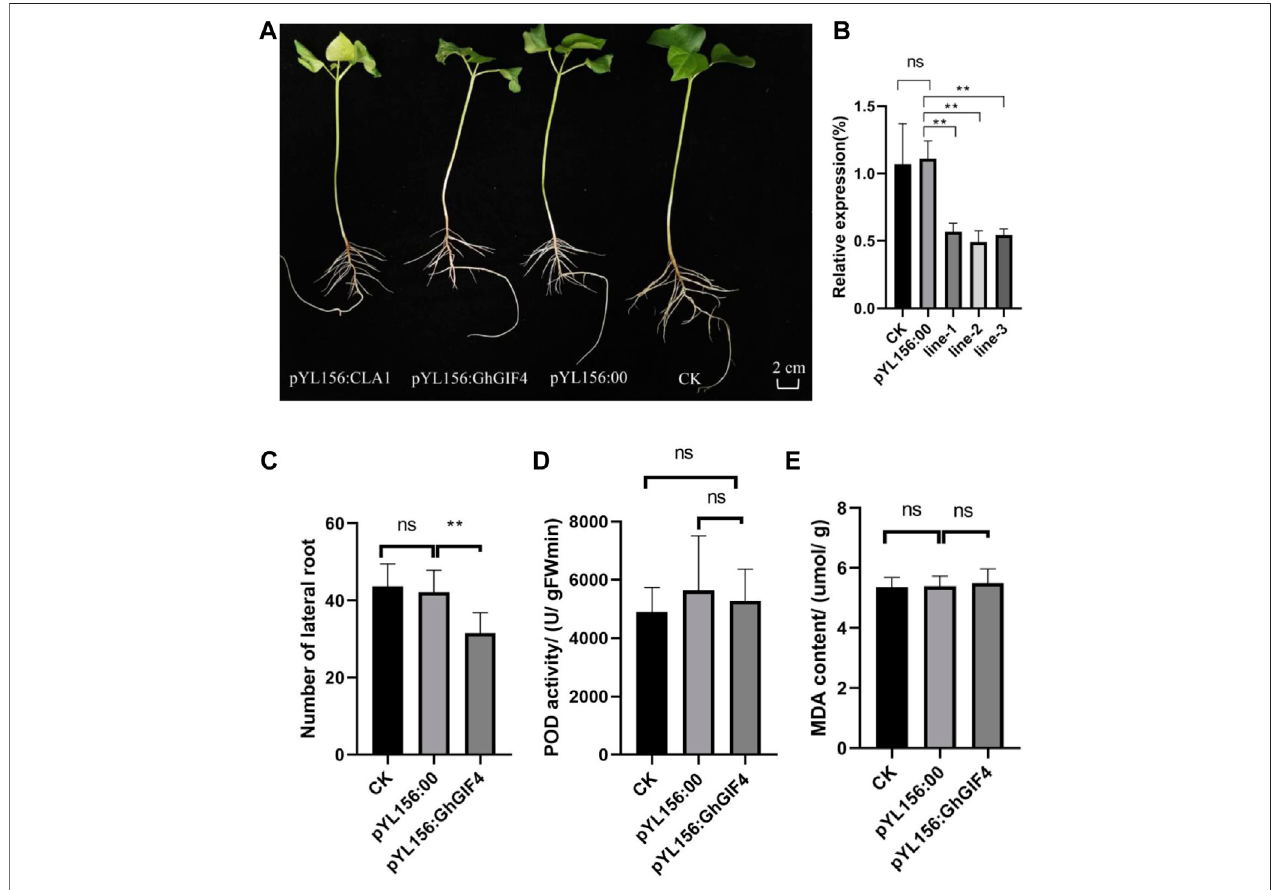
FIGURE7| Virus-inducedGeneSilencing(VIGS)of GhGIF4 incotton. (A) Thephenotypeofthegenesilencingplants (B) Relativeexpression of GhGIF4 insilenced and its control plants (C) The number of lateral roots (D) POD activity (E) MDA content. Note, all values represented the mean ± s.d. (n ≥ 3 replicates), ns represent not signi fi cant, p represent signi fi cance at p < 0.05